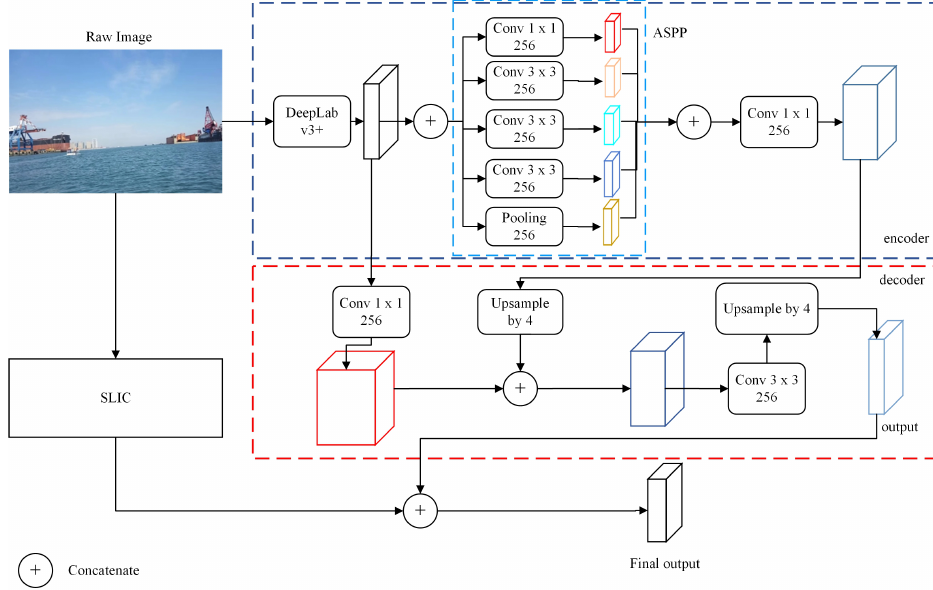
Figure 3. The proposed semantic segmentation architecture: the SLIC algorithm module is mounted on the outside of the deep neural network and refines its